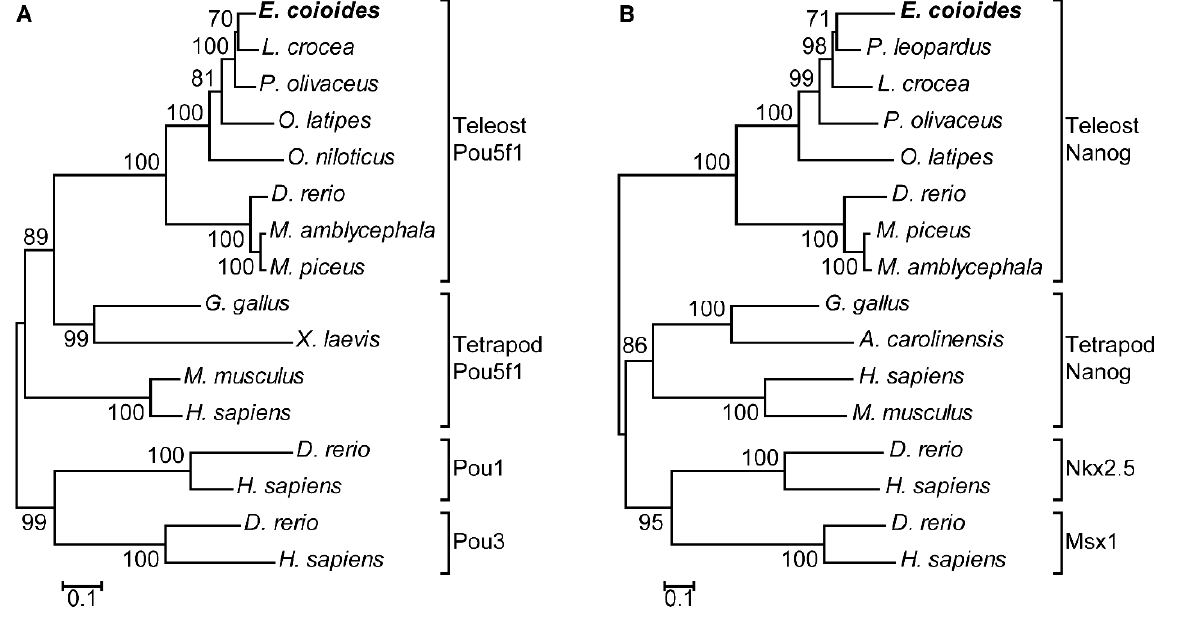
Figure 4. Phylogenetic trees of ( A ) EcPou5f1 and ( B ) EcNanog. Phylogenetic trees were deduced by MEGA version 5.0 using the neighbor-joining method with 1500 bootstrap replicates. Numerals at bifurcation points of phylogenetic tree are bootstrap values. The species names in the first line indi- cate the EcPou5f1 and EcNanog proteins of orange-spotted grouper. GenBank accession numbers